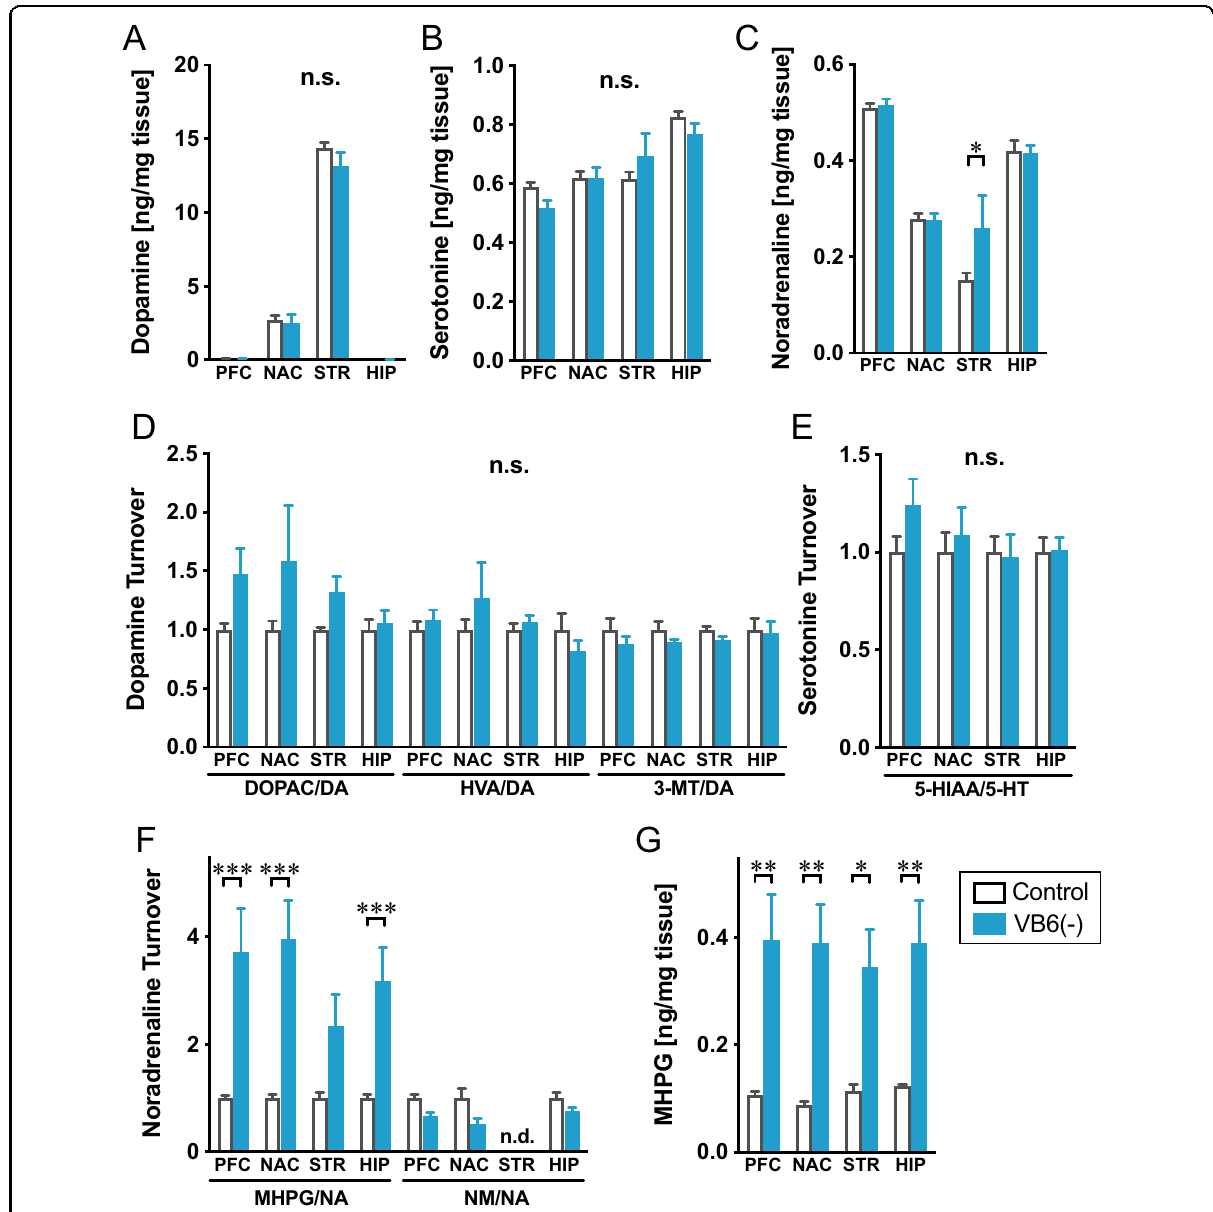
Fig. 2 Monoamine levels in the brain of VB6-de fi cient mice. A DA, B 5-HT, and C NA contents, D DA, E 5-HT, and F NA turnover and G MHPG contents in various regions of the mouse brain were determined. * p < 0.05, ** p < 0.01 and *** p < 0.001 using Bonferroni ’ s multiple comparison test ( n = 6). The data were represented as the mean ± SEM values. n.d. not